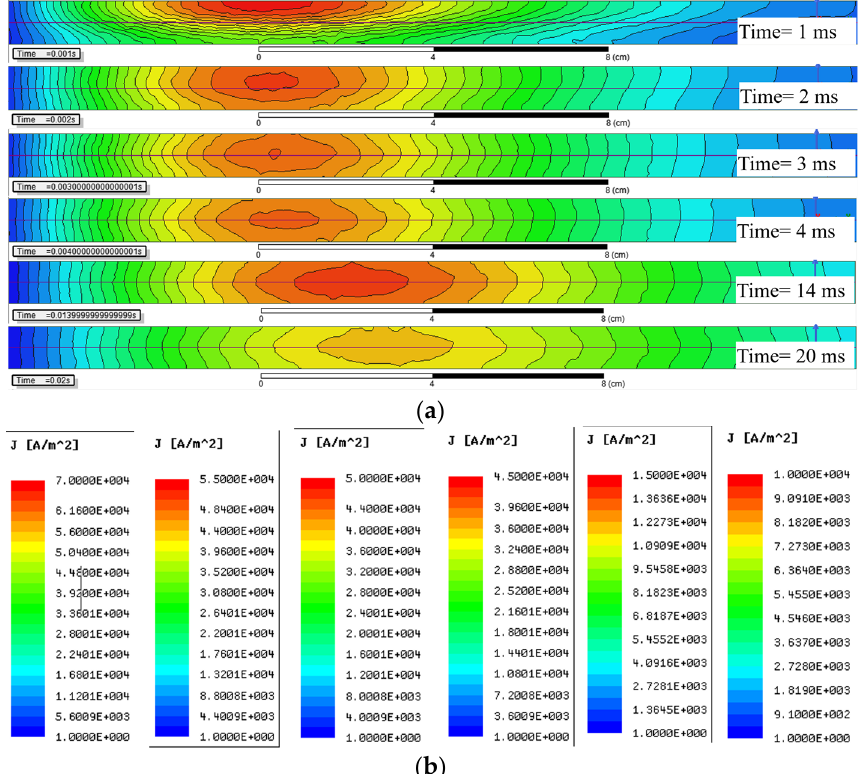
Figure 3. The distribution of eddy current density (ECD) in an aluminum plate with d = 10 mm. ( a ) ECD in the Z0Y section diffuses similar to a smoke ring during the interval of pulse excitation. ( b ) The color scale corresponding to the time shown in ( a ), the minimum value of ECD is limited to 1 A/m (cid:2870) , and the maximum values are set to 7 × 10 (cid:2872) A/m (cid:2870) , 5.5 × 10 (cid:2872) A/m (cid:2870) , 5 × 10 (cid:2872) A/m (cid:2870) , 4.5 × 10 (cid:2872) A/m (cid:2870) , 1.5 × 10 (cid:2872) A/m (cid:2870) and 1 × 10 (cid:2872) A/m (cid:2870) , respectively.